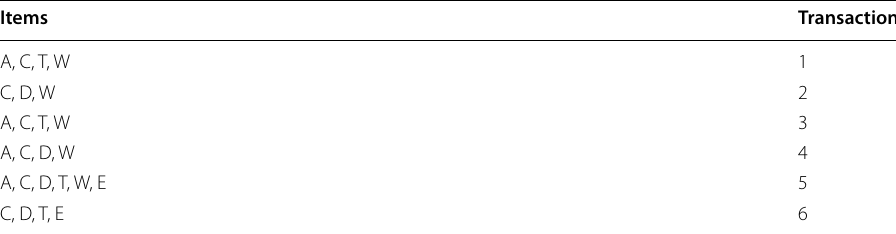
Table 3 A sample DB dataset with six transactions [25]